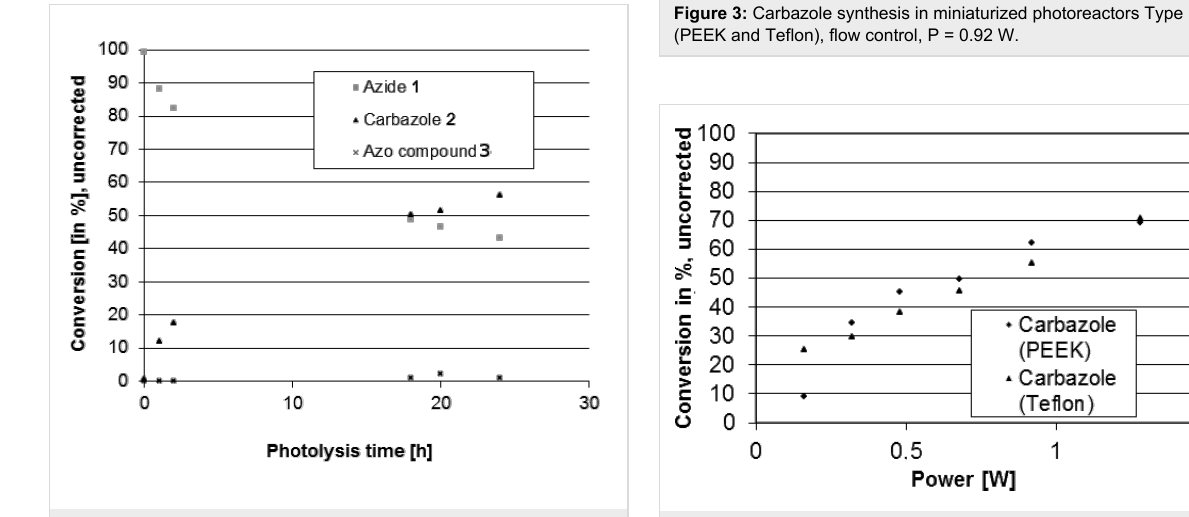
Figure 2: Photolysis results in batch setup (flask) with a xenon lamp (400 W, λ > 345 nm).